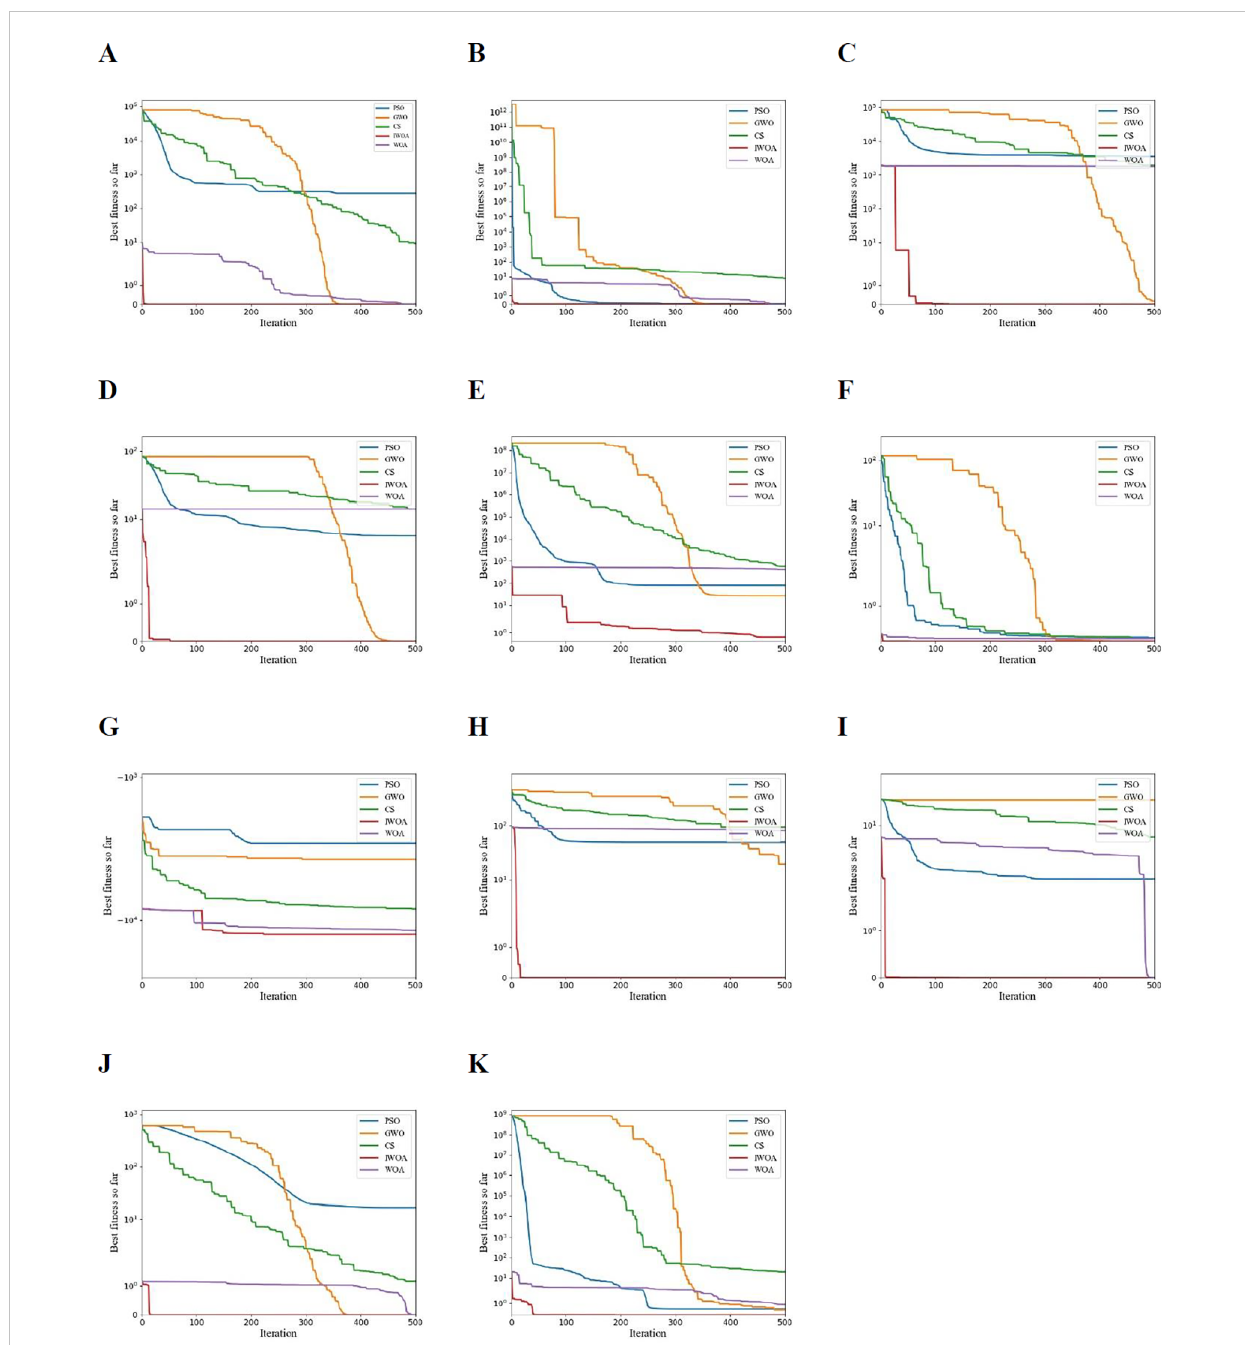
FIGURE 5 Convergence curves of different optimization algorithms on 11 test functions, (A – K) correspond to f 1 ~ f 11